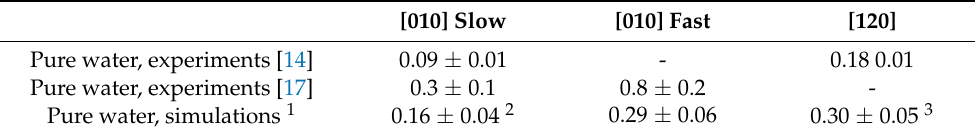
Table 2. Step velocities on barite surface, KMC simulations and experimental measurements at 30 ◦ C [14], 10 − 1 nm/s.